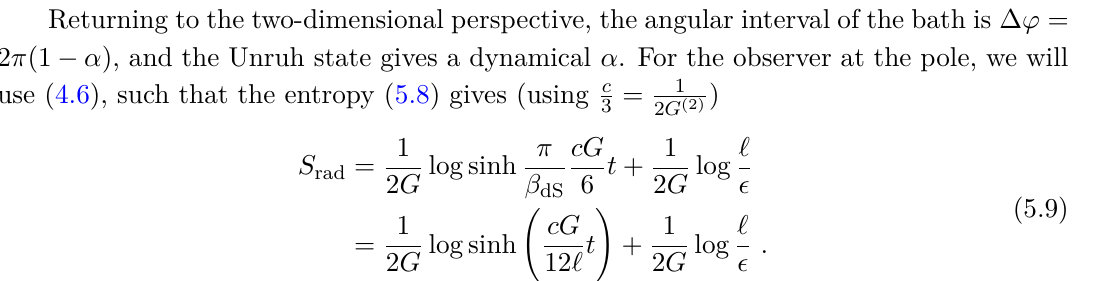
Figure 6 . A timeslice of the three-dimensional static patch in our partial reduction approach. In the dual description, radiation moves along the stretched horizon. This has the effect of shifting the dividing line between bath and JT gravity. The entanglement between these two systems is a function of the angle ϕ (parametrised by α ), which dynamically decreases during the evaporation process. We also indicated the part of the 3D geometry that has been reduced over, to clarify the entanglement